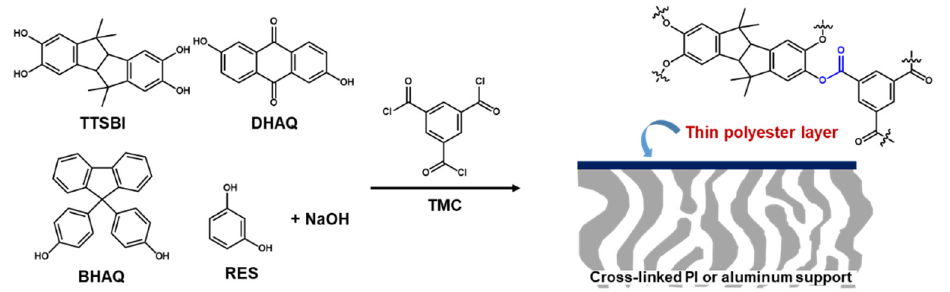
Figure 4. Phenol-based polyester selective layer with interconnected voids and the